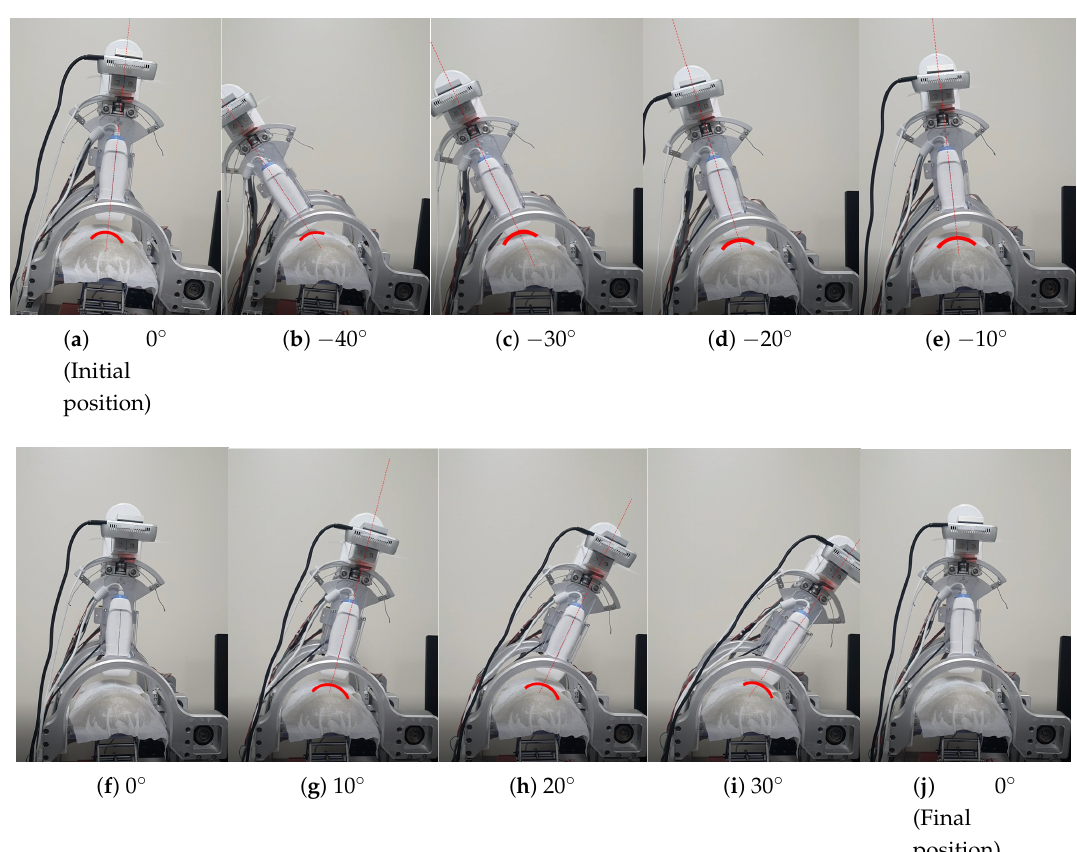
Figure 9. Eight-point scanning snapshots (the red arcs in ( a – i ) represent the point cloud acquired by